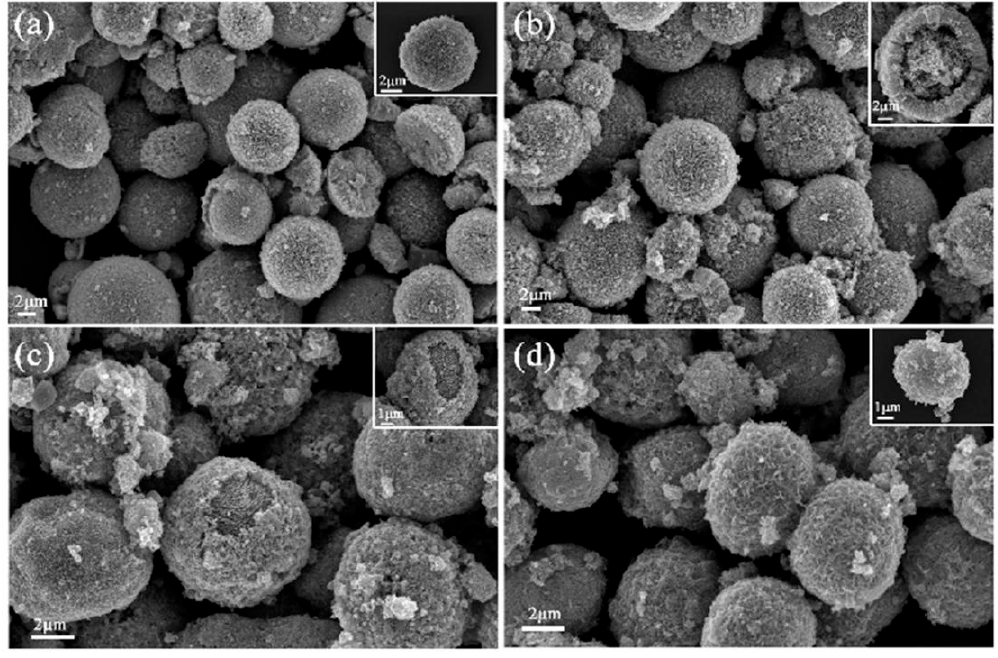
Figure 2. The SEM images of the ( a ) pure ( b ) 0.5 at% ( c ) 1 at%, and ( d ) 2 at% Ni–ZnO.